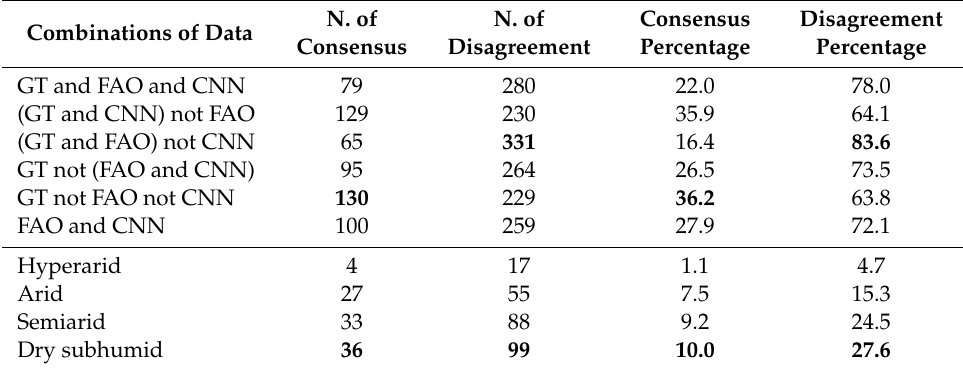
Table 2. Consensus of the estimated tree cover class in 359 plots (396 without 37 plots with uncertain class with score < 50%). GT is ground truth, CNN is the best results of our CNN-based model, and FAO is the FAO’s Global Dryland Assessment from Bastin et al.